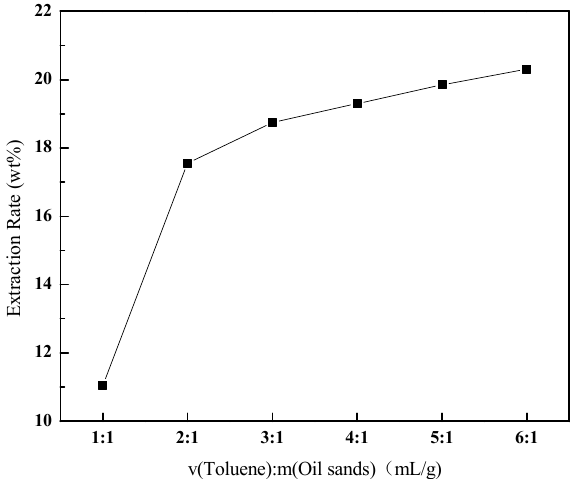
Figure 4. E ff ect of the ratio of toluene to oil sands on the extraction rate of bitumen.